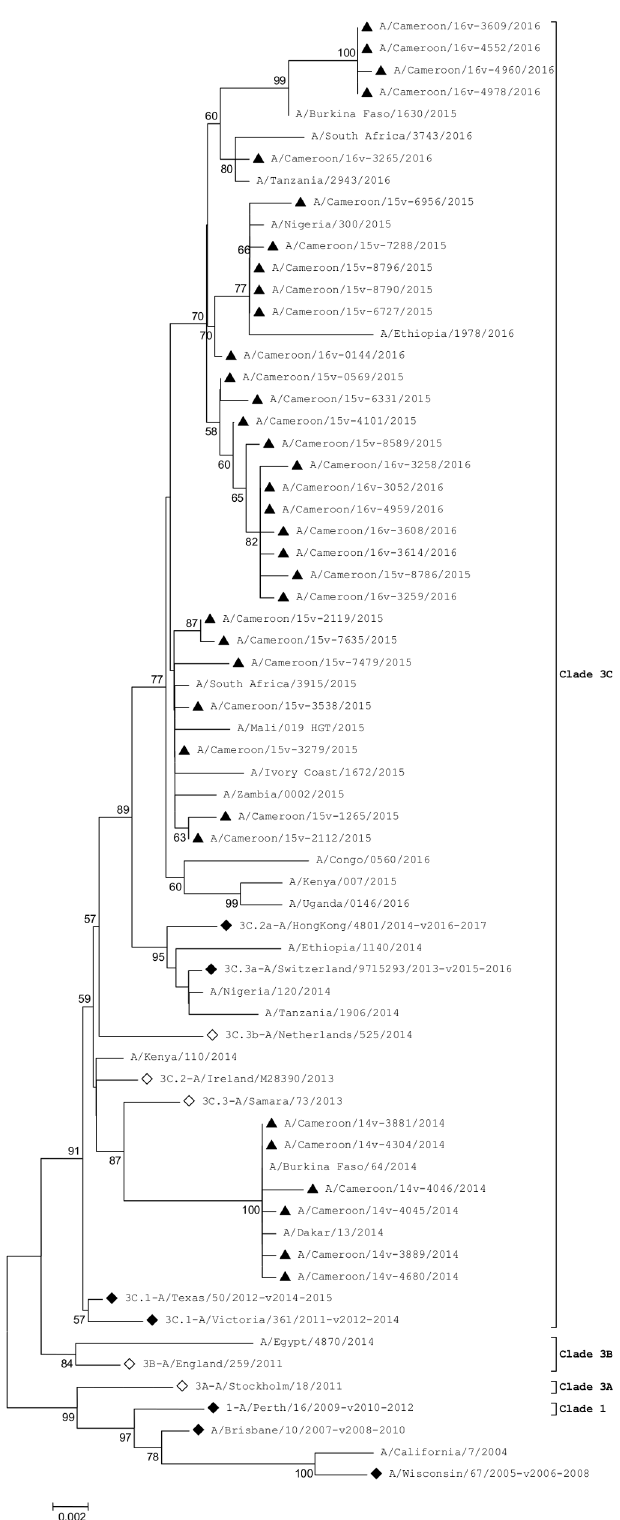
Fig 2. Phylogenetic analysis of NA nucleotide sequences of influenza A(H3N2). ^ represent reference strains of known clades, ♦ represent the Northernhemisphere vaccine strains recommended by WHO and ▲ representCameroonian